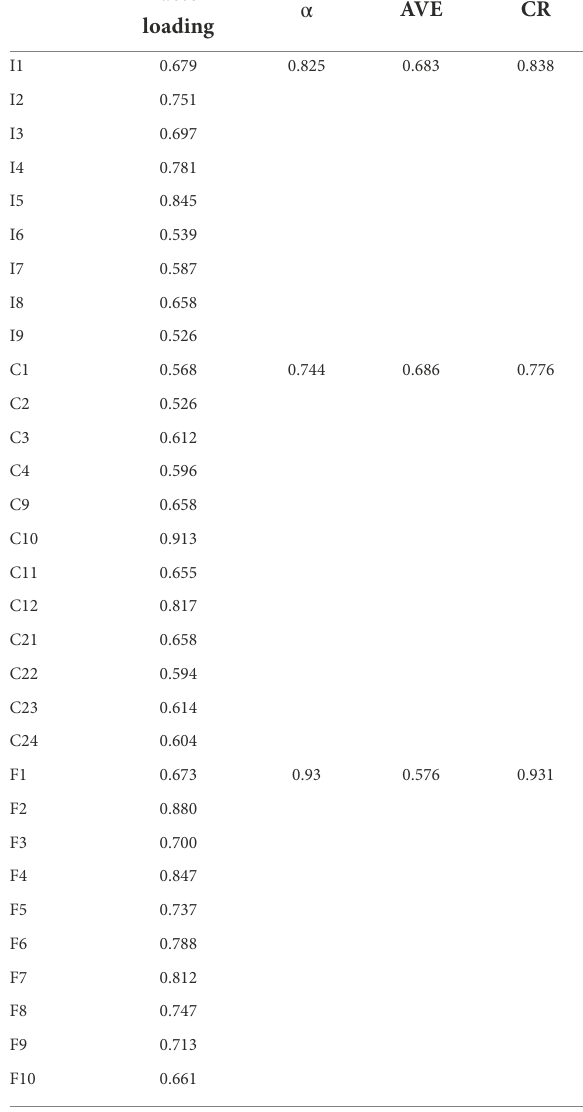
TABLE 2 Factor loadings and reliability of the questionnaire items.